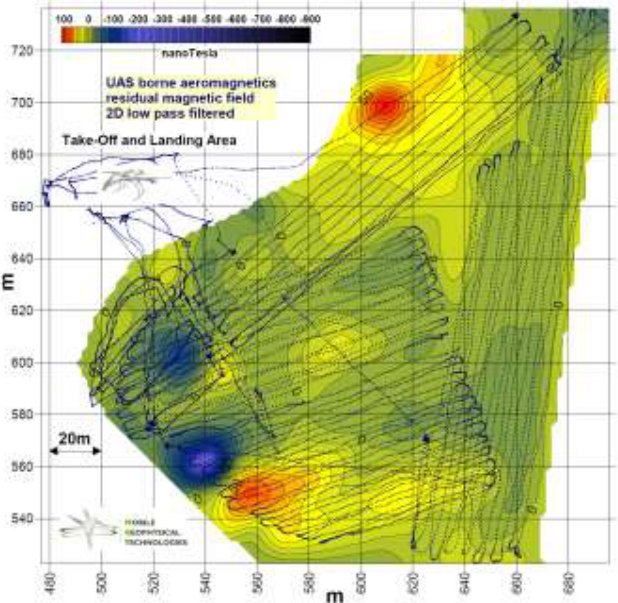
Figure 2D-isoline plot of the residual magnetic field. The magnetic data were collected along the tracks on five sections. The clearance between ground and sensor varied between 2 to 5m. The magnetic anomalies reveal the positions of an electric railway engine, the debris mass of family houses and other